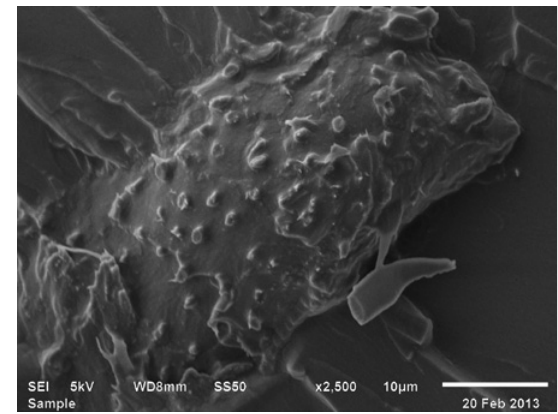
Figure 3 SEM micrograph for (CY-230+8 wt% HY-951+0.5 wt%